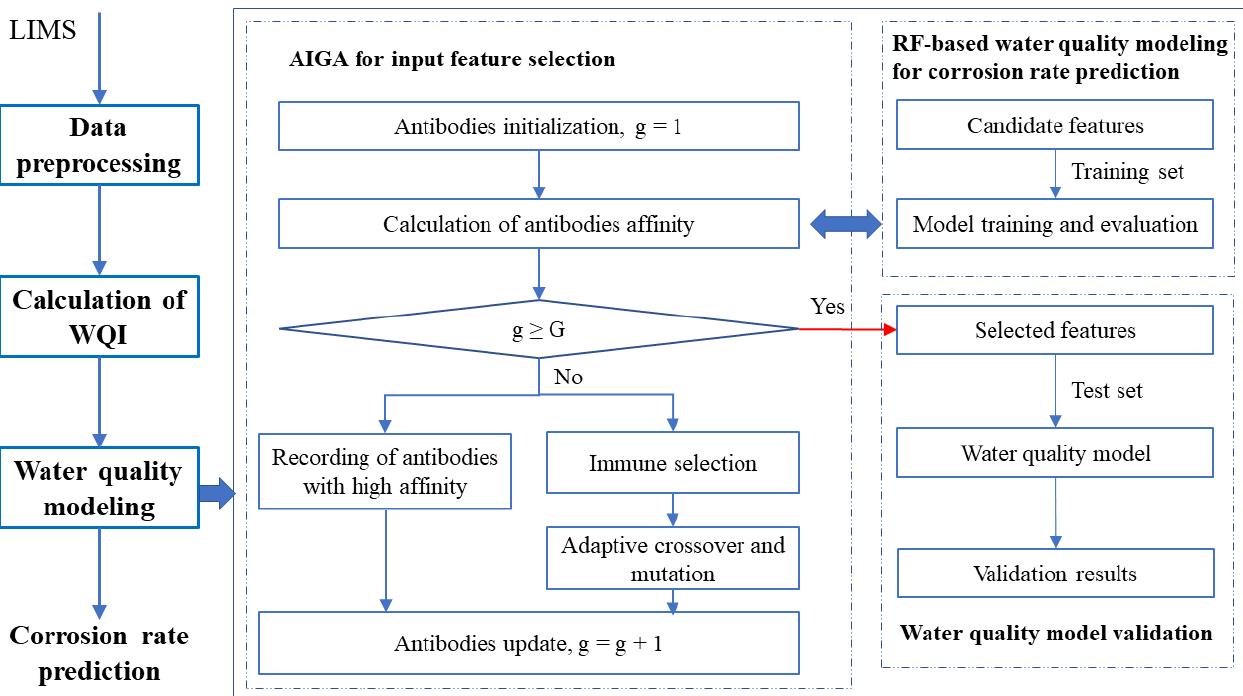
Figure 1. Proposed AIGA-RF water quality modeling methodology.